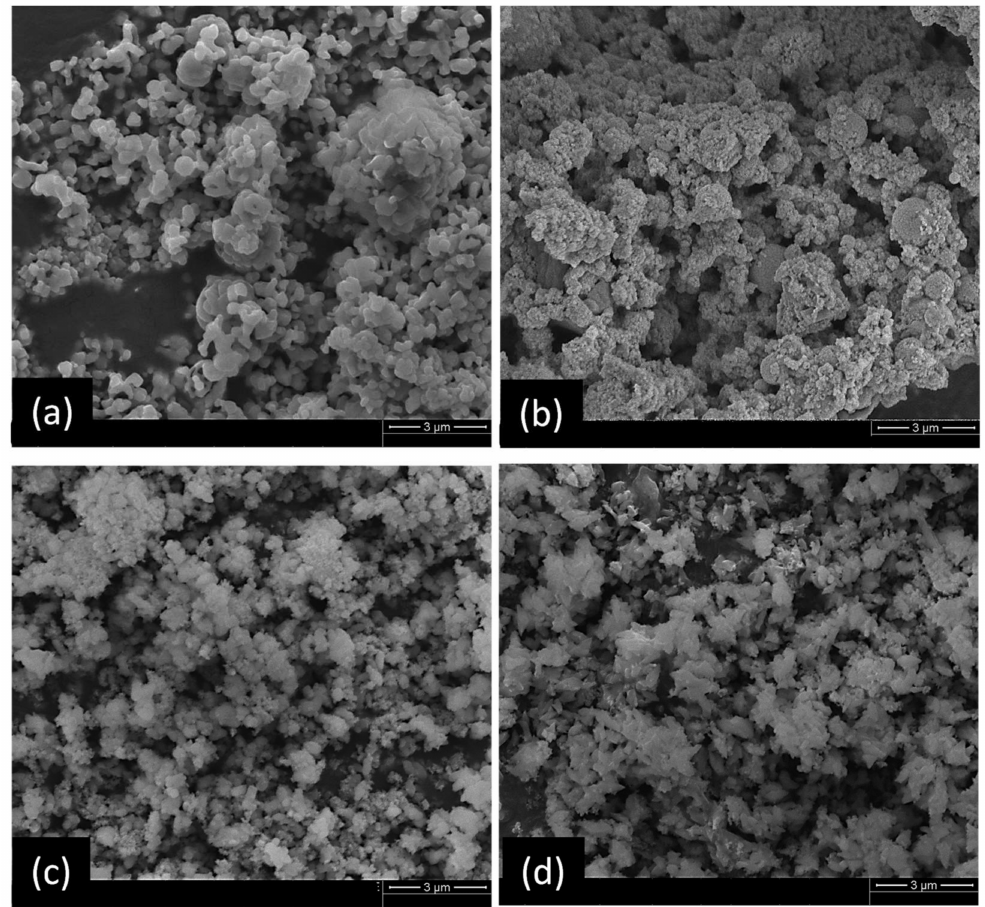
Figure 1. SEM images of as-prepared calcium-based sorbents: ( a ) CaTi-1.2, ( b ) CaTi-2, ( c ) CaTi-3, ( d )